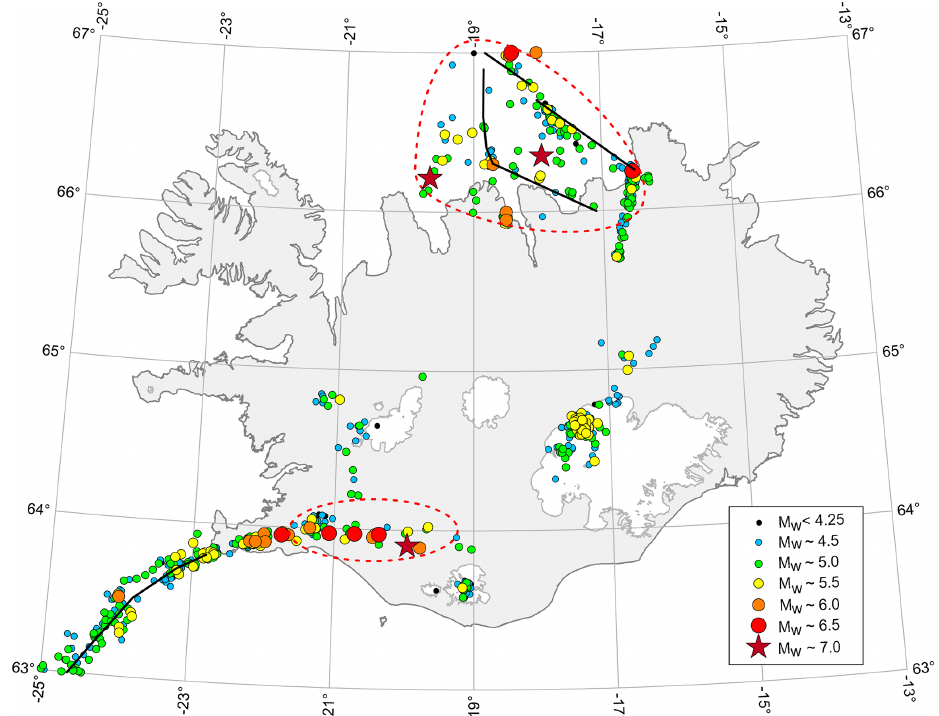
Figure 5. Earthquakes in or near Iceland during 1900–2019 listed in the new catalogue. For the first part of the period, location coordinates are often given in round numbers (tenths of degrees or even half or whole degrees). The map shows slightly jittered locations ( ≤ 3km, except when M w > 5 . 75) to avoid superimposing different events. The magnitude range for the smallest earthquakes is M w 4–4.25. For the other ranges the central value is specified so that, for example, M w ∼ 4 . 5 implies the range 4.25–4.75. The largest event is M w 7.00 in the TFZ at 18 ◦ W. The indicated tectonic features are explained in Fig.